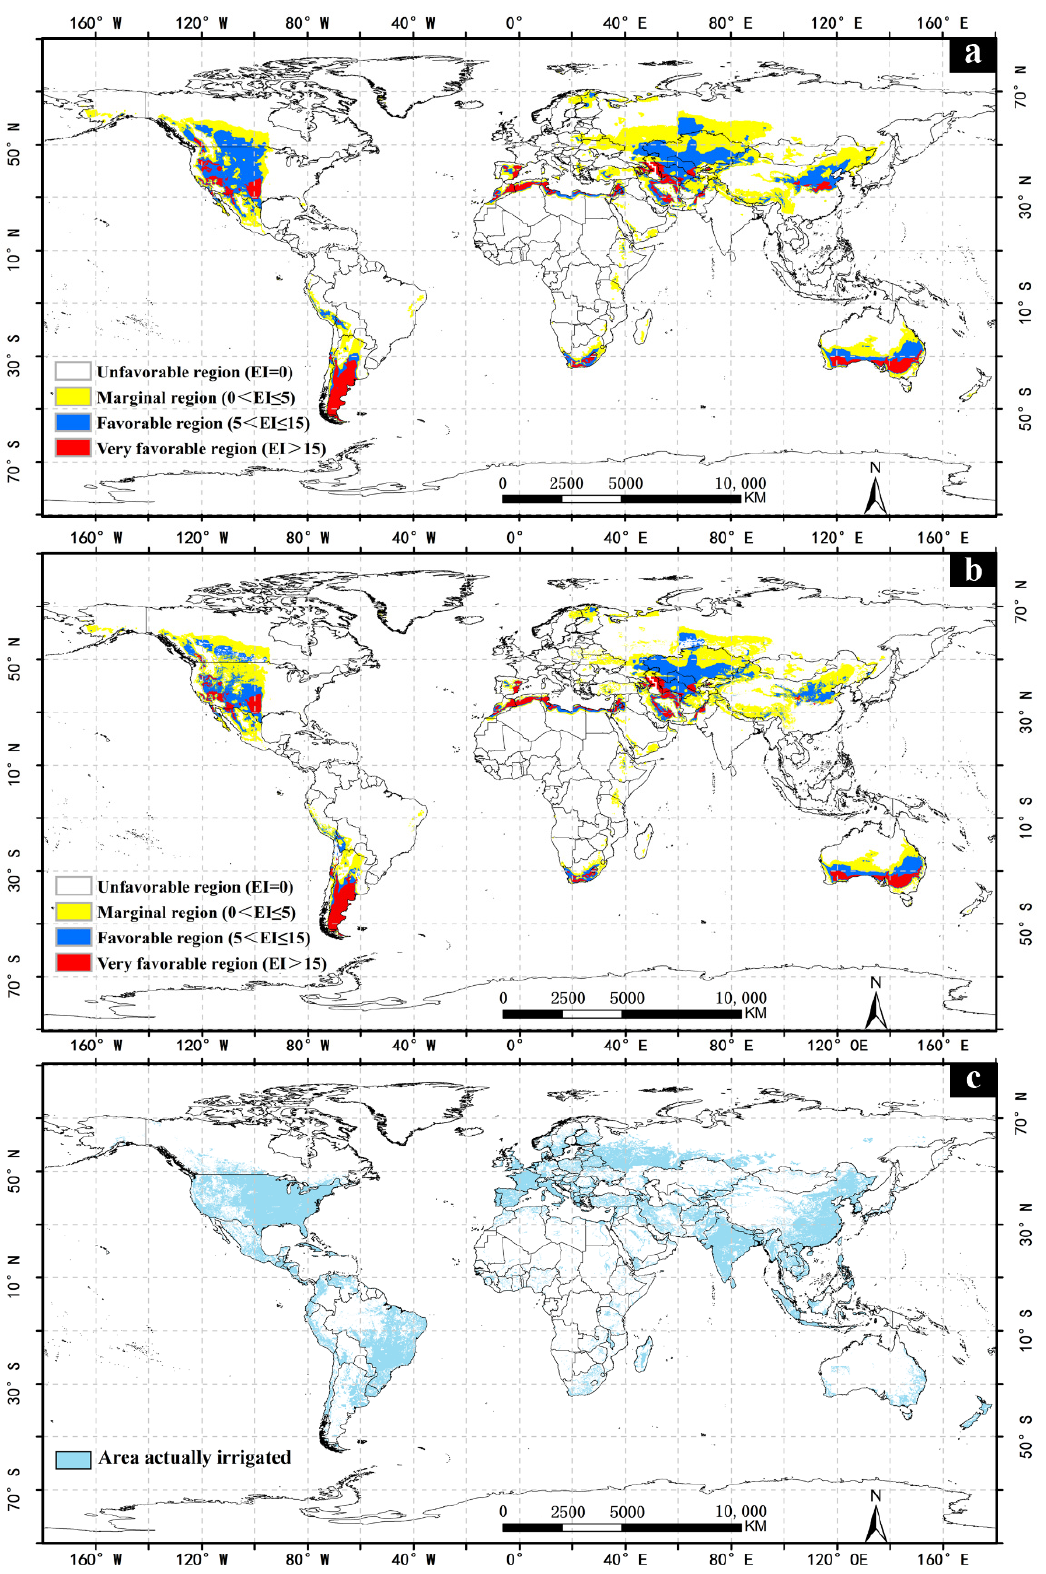
Figure 2. Potential global distribution of Apocheima cinerarius under the historical climate. ( a ) Projected global distribution of Apocheima cinerarius assuming natural rainfall; ( b ) projected global distribution of Apocheima cinerarius with irrigation; ( c ) global map of irrigation areas.